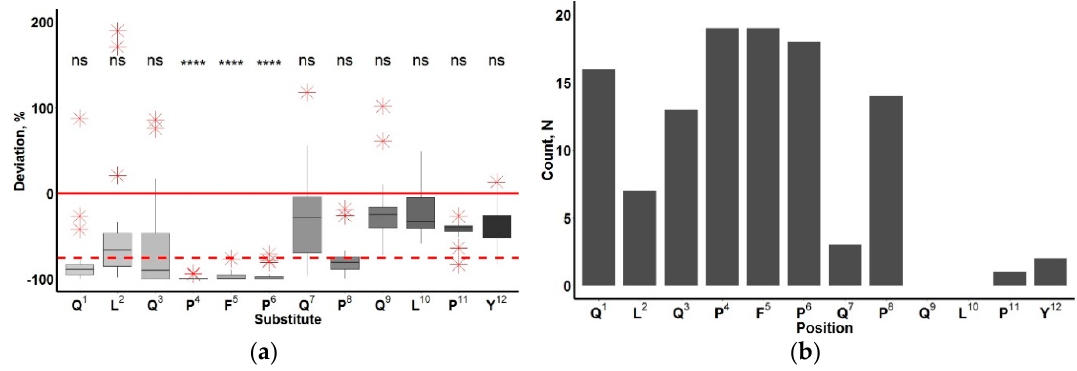
Figure 2. Quantitative change in the binding of an antibody to the QLQPFPQPQLPY peptide upon introduction of amino acid substitutions. ( a ) percent deviation of affinity from the original peptide; outliers are marked with a red asterisk, Mann–Whitney test significance levels are black: ns: p > 0.05; ****: p ≤ 0.0001; ( b ) number of amino acid substitution variants in the peptide, leading to a 75% decrease in the affinity of the antibody to it.